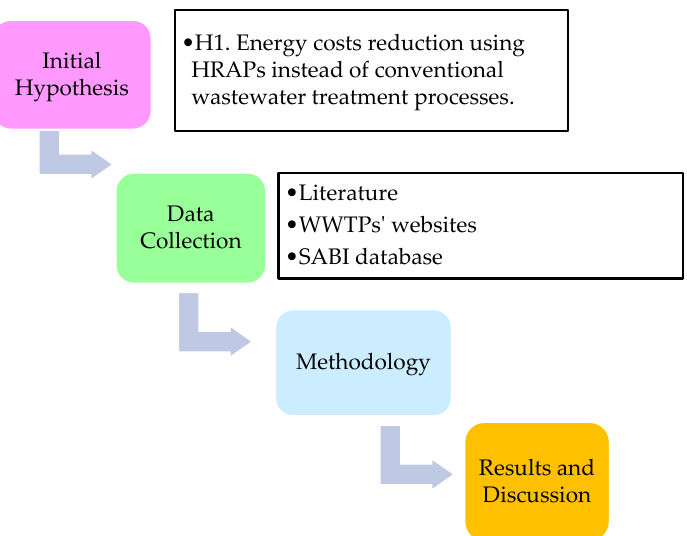
Figure 1. Schematic representation for the methodology.